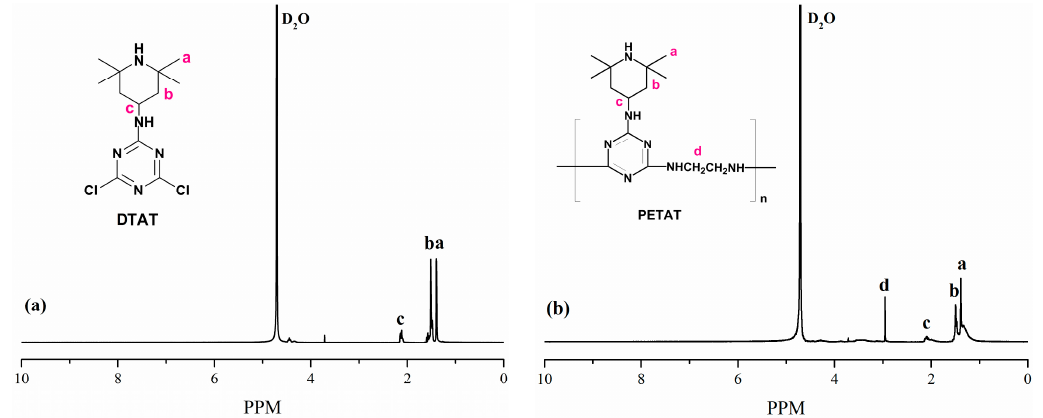
Figure 3. 1 H NMR spectra of ( a ) DTAT (2,4-dichloro-1,3,5-triazine-p-4-amino-2,2,6,6-tetramethylpiperidine) and ( b ) PETAT.